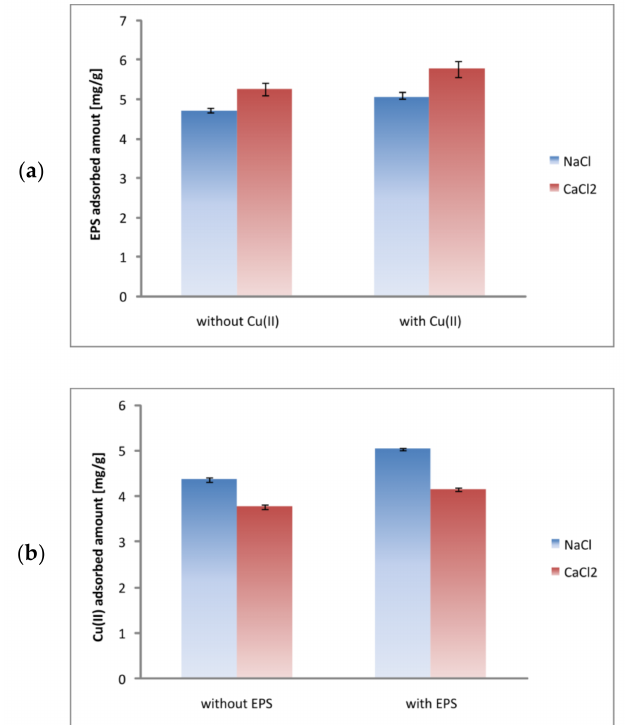
Figure 3. EPS adsorbed amount [mg/g] without and with Cu(II) ions (100 mg/L) ( a ) as well as Cu(II) adsorbed amount [mg/g] without and with EPS (100 mg/L) ( b ) in various supporting electrolytes (0.001 M NaCl or CaCl 2